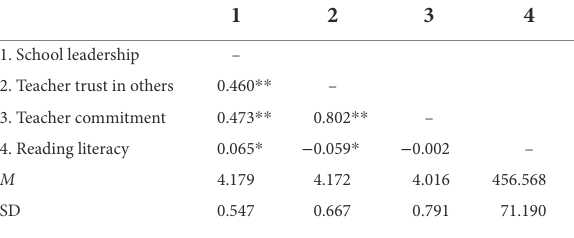
TABLE 1 Descriptive statistics and pearson correlations among study variables.